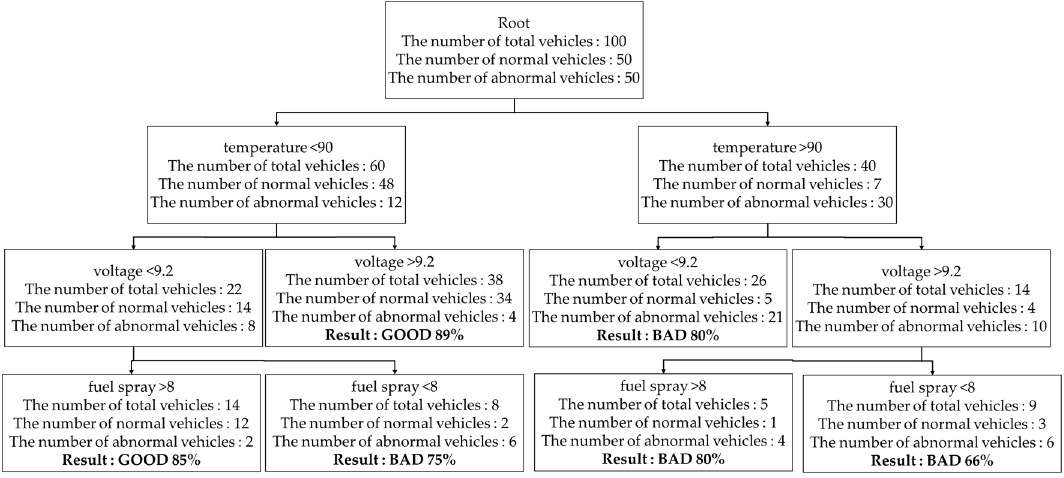
Figure 9. The decision-making tree generated based on temperature, voltage, and fuel spray.